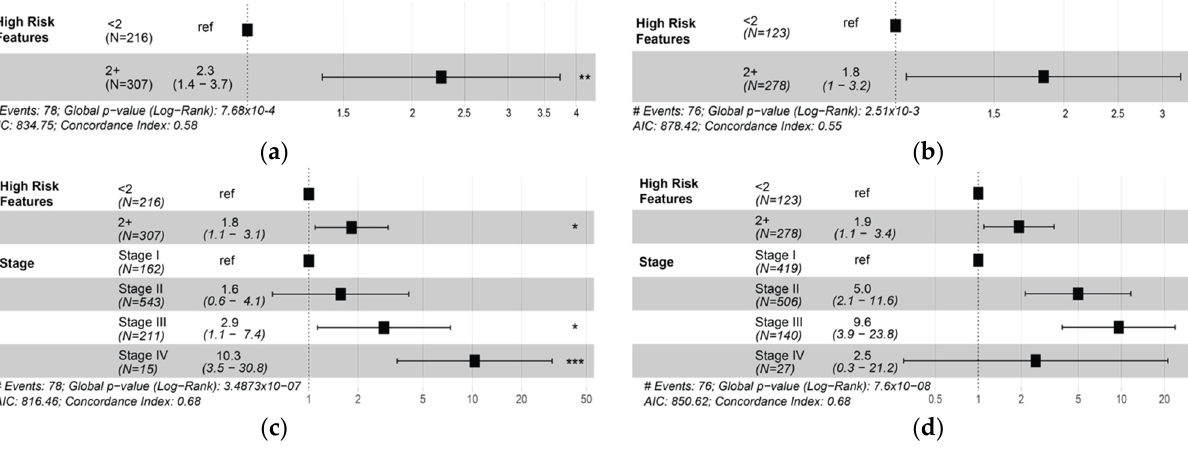
Figure 6. The presence of two or more ‘high-risk’ spatial features provides independent prognostic information. High-risk feature scores include low intratumoral TILs (scores of 0 or 1), absence of TIL forests (0), presence of immune cold TIL deserts (1), and low peritumoral TIL scores (0 or 1). ( a , b ) Forest plots of hazard ratios (estimates and 95% CIs) from a univariate Cox proportional hazards model of progression-free interval (PFI) comparing cases with two or more high-risk features (2+) to those with ≤ 1, as shown in ( a ) TCGA and ( b ) UNC CBCS. ( c , d ) Forest plots of hazard ratios (estimates and 95% CIs) from a multivariate Cox proportional hazards model of progression-free interval (PFI). The dotted line indicates a hazard ratio of 1, where ( c ) TCGA and ( d ) UNC CBCS. *** = p < 0.001, ** = p < 0.05, * = p < 0.01